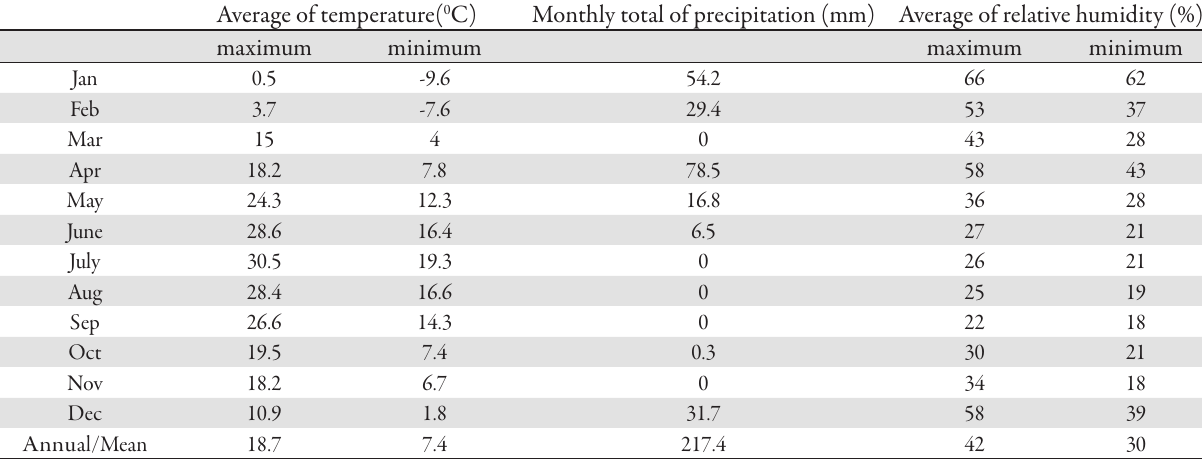
Tab. 1. Long-term (1978-2008) meteorological data in Gonabad,